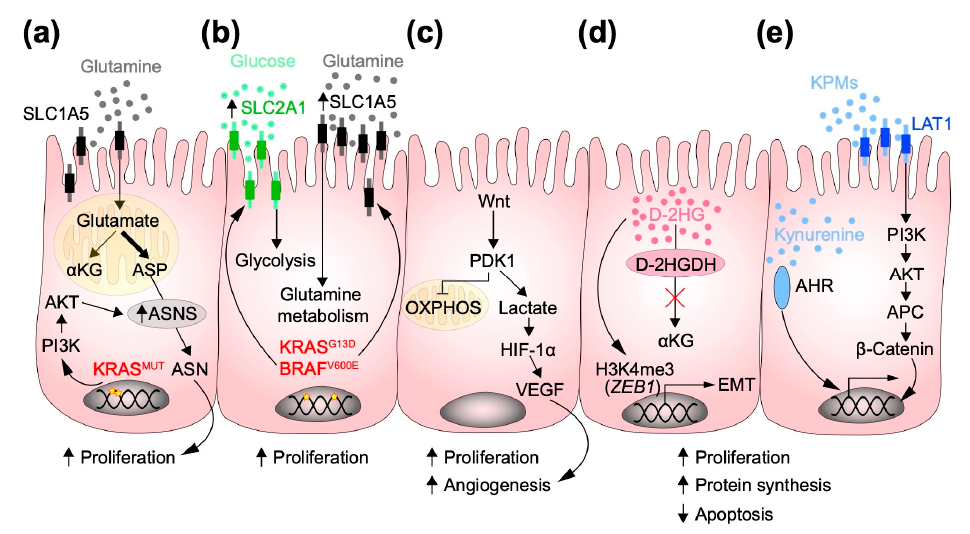
Figure 1. Schematic representation of how autonomous oncometabolites affect the development of CRC: ( a ) In the absence of glucose, the oncogenic Kras signaling upregulates the expression of asparagine synthetase (ASNS), the enzyme involved in conversion of aspartate (ASP) to